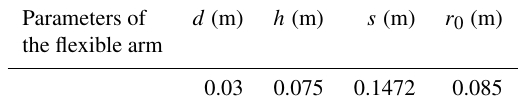
Table 2. Geometric parameters of the